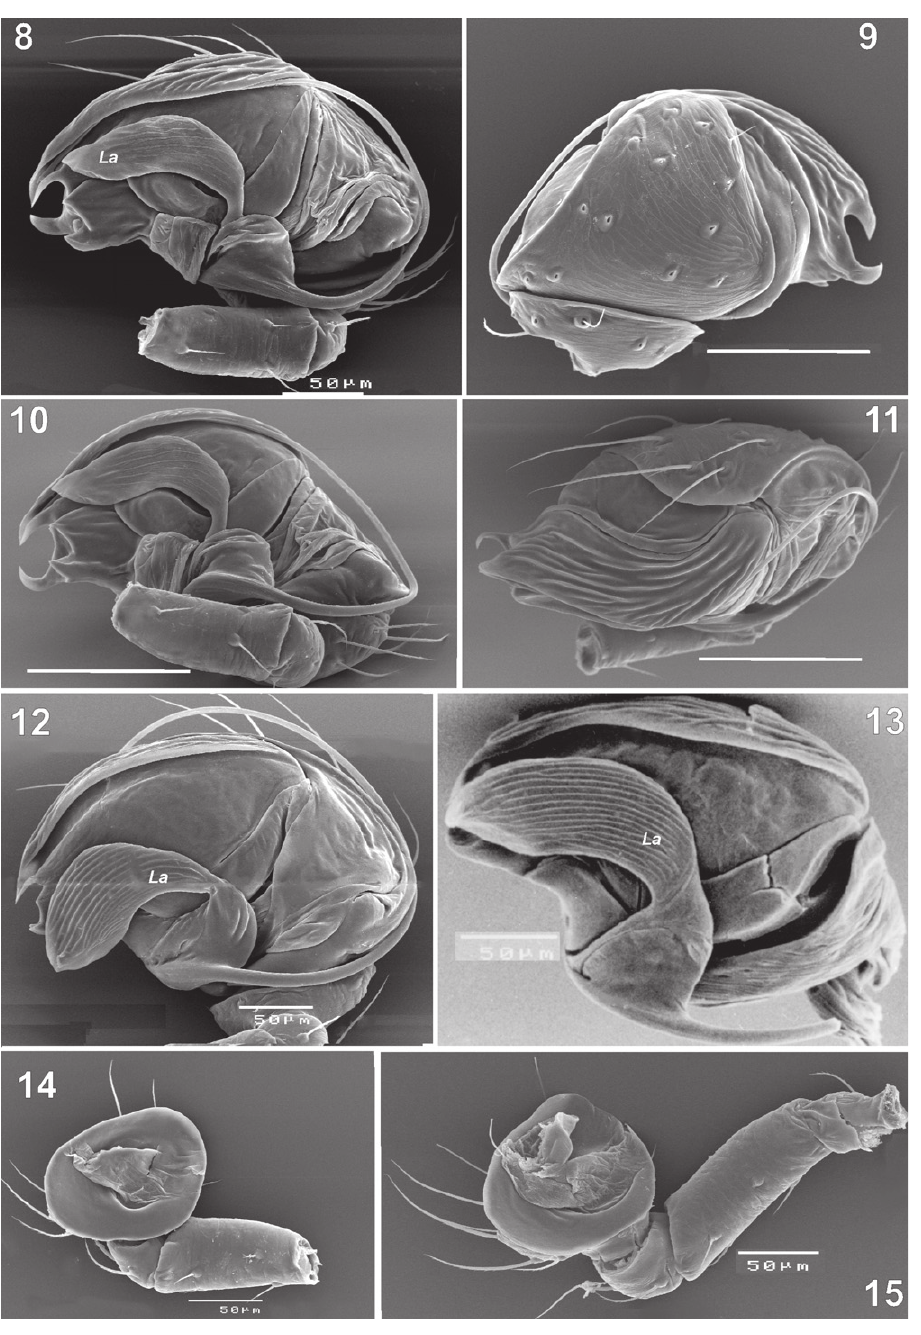
Figures 8–15. Scanning electron microphotographs of the male palp of Synaphris wunderlichi sp. n. ( 8– 11, 14 ), S. lehtineni ( 12, 15 ) and S. orientalis ( 13 ). 8, 12–13 prolateral 9 retrolateral 10 caudal 11 anterior 14–15 palp with removed bulbus showing femur-tibia, anterior. Scale = 0.1 mm if not otherwise